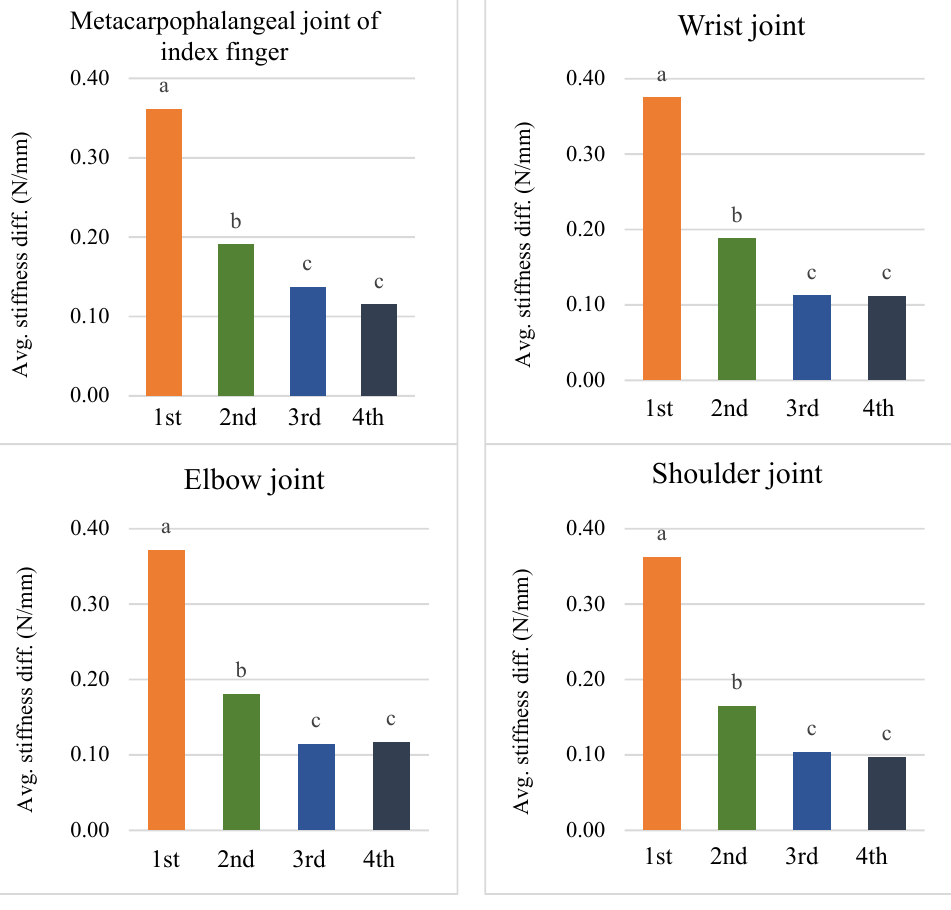
Figure 8. Relative stiffness difference between two virtual cylinders in quarterly subsets of the total number of trials. Means labeled without a common letter are significantly different ( p < 0.05).